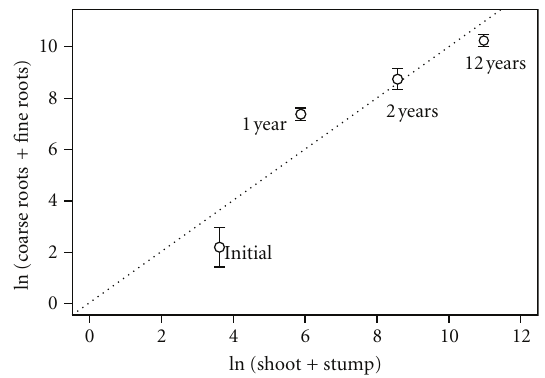
Figure 5: Plot of the aboveground (stump + shoot) versus the belowground biomass (coarse + fine roots) of seedlings (Initial), a one-, two-, and a 12-year-old stand of black locust ( Robinia pseudo- acacia